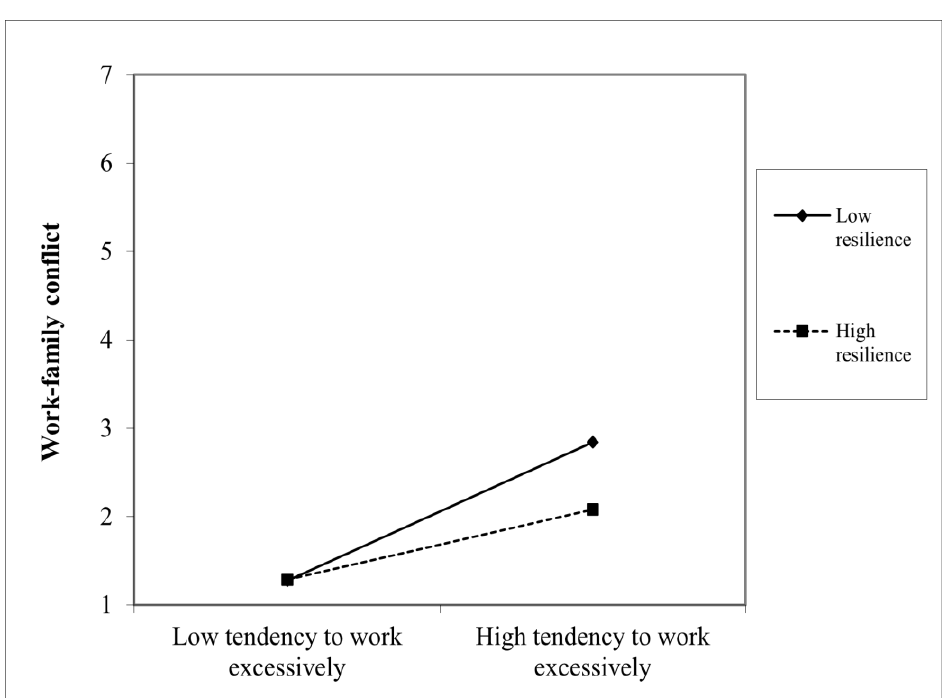
Figure 3. Moderating effects of resilience on the relationship between working excessively and work-family conflict